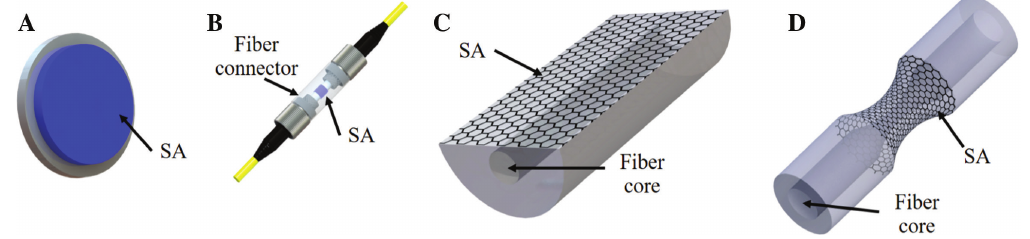
Figure 3: Incorporation methods. (A) Spin coating 2D materials on mirrors or quartz. (B) Sandwiched structure. Transferring saturable absorber (SA) on (C) D-shaped fibers and (D) tapered fibers.